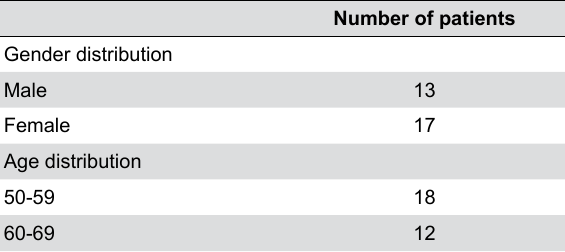
patients according to sex and age were recorded (Table 2). Data on NCCLs according to tooth type, arch, degree of angle, cervicoincisal height, buccolingual depth, and restorative systems are presented in Table 3.